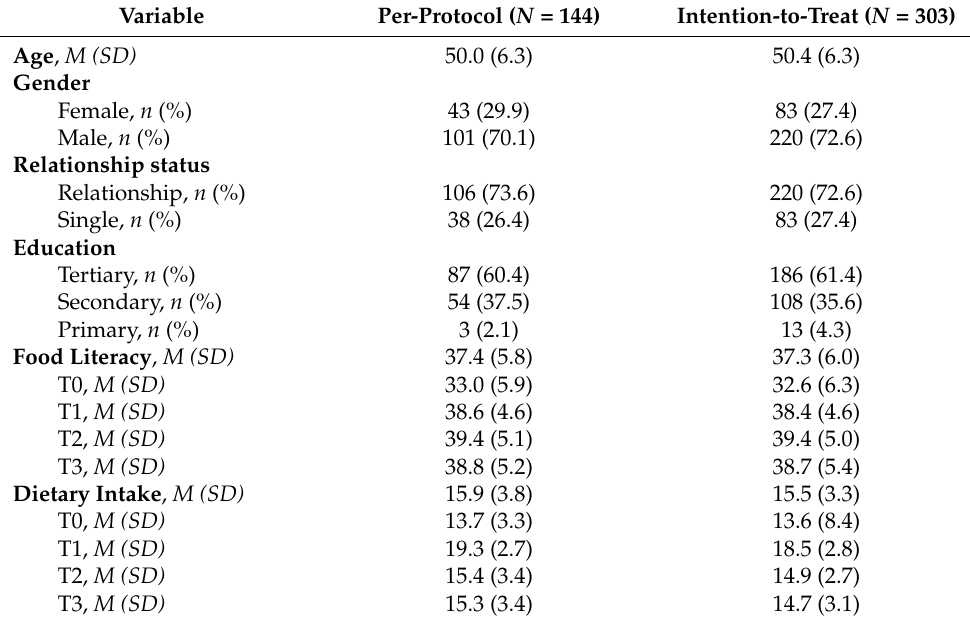
Table A1. Descriptive comparison of per-protocol and intention-to-treat data